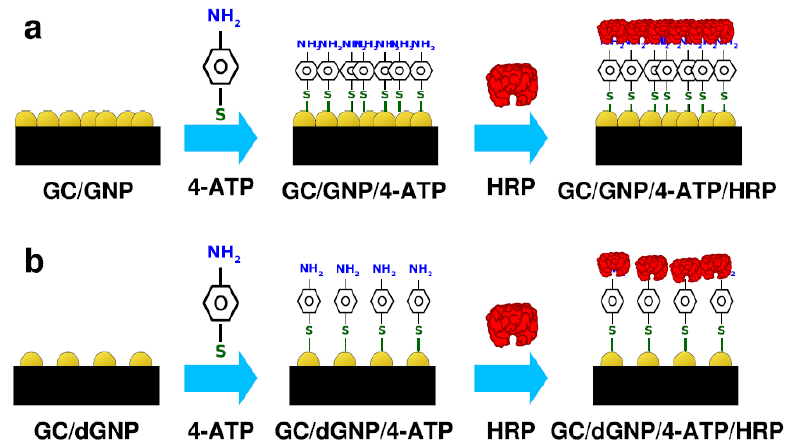
Figure 6. Immobilization of horseradish peroxidase (HRP) on gold nanoparticle (GNP) deposits modified with 4-aminothiophenol (4-ATP). Two different GNP arrangements on the glassy carbon (GC) electrode are represented: ( a ) random and ( b ) well-dispersed GNP electrodeposits. Reprinted from Huerta-Miranda et al. [94], Copyright (2018), with permission from